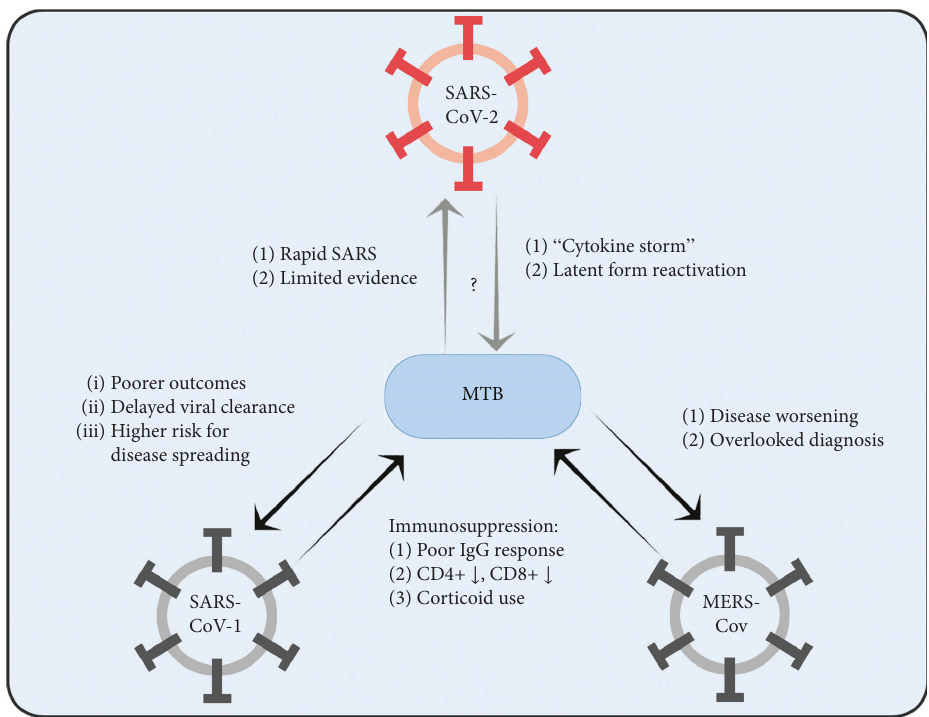
Figure 2: Known and possible interactions between MTB and